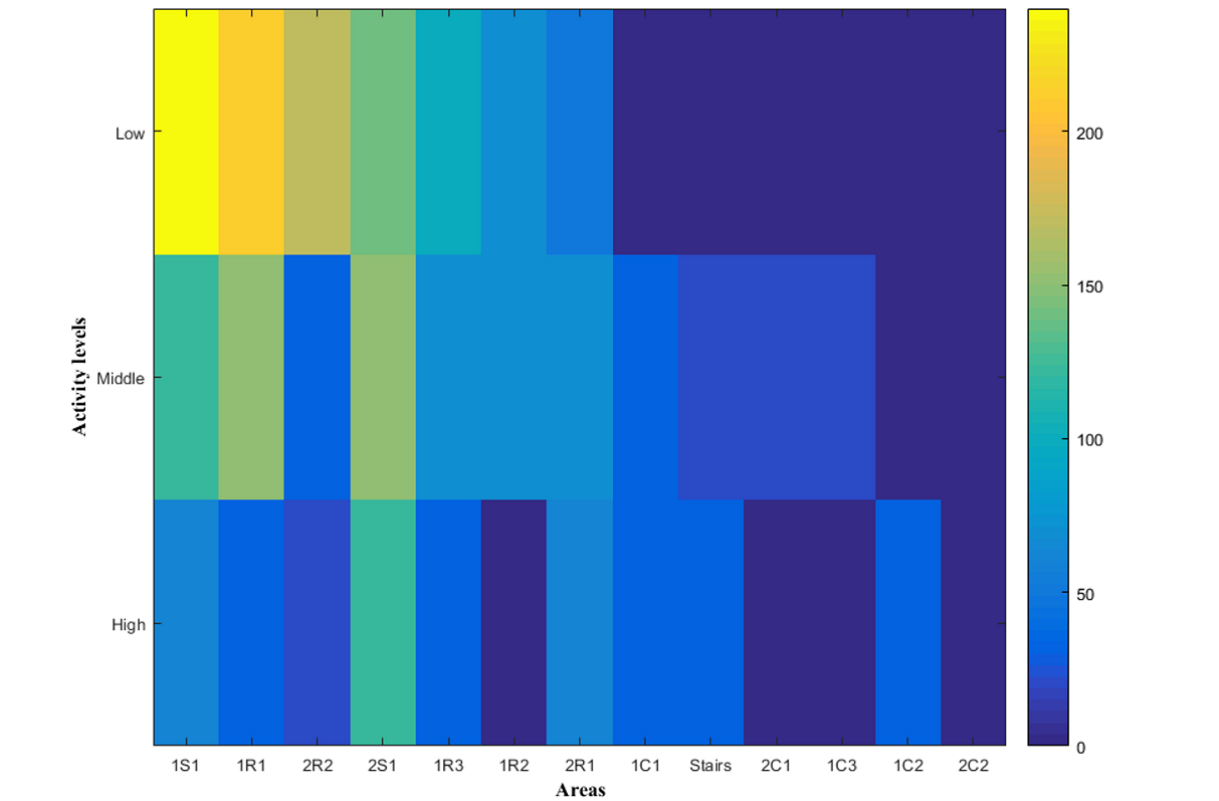
Figure 9. Lasagna plots representing the combination of localization tracking and activity levels. Areas are sorted in descending order depending on the absolute time. The color between blue (time equal to zero) and yellow (time equal to 230 s) represents the activity level spent-time.